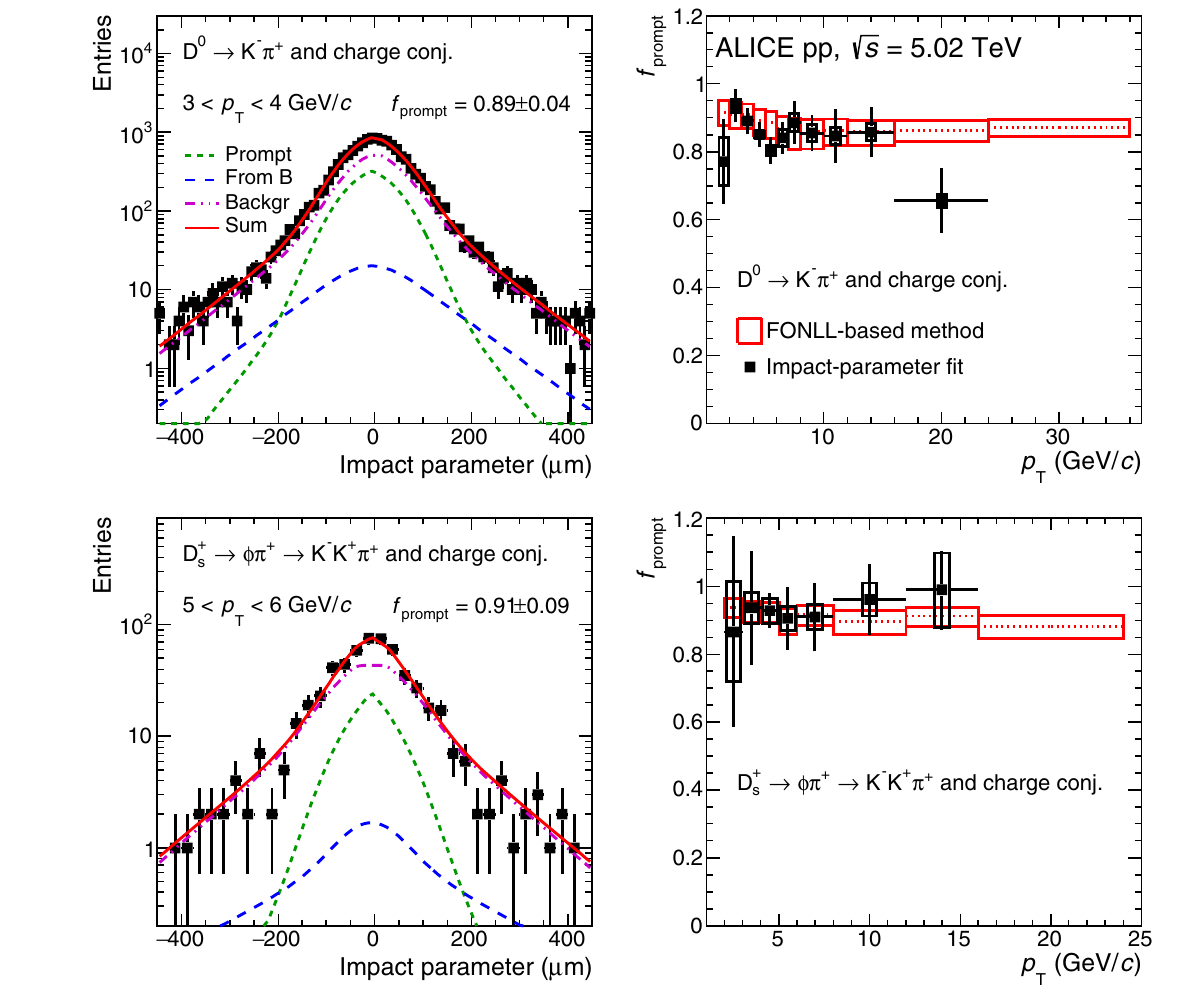
Fig. 5 Left: examples of fits to the impact-parameter distributions of D 0 and D + s candidates. The curves show the fit functions describing the prompt, feed-down, and background contributions, as well as their sum, as described in the text. Right: fraction of prompt D 0 and D + s -mesons raw yield as a function of p T compared to the values obtained with the